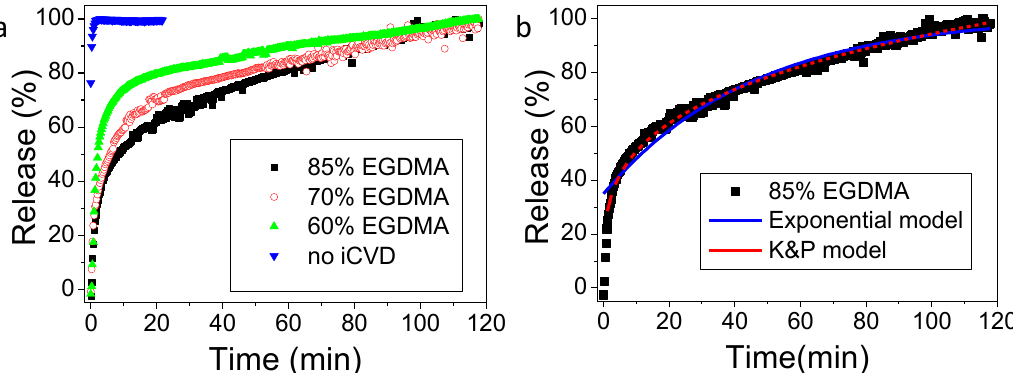
Figure 3. Conductance variation due to the release test from (a) initiated chemical vapor deposition (iCVD) coating alone (white dots) and (b) drug layer with iCVD coating on top (continuous line). Drug layer obtained by drop casting (drop volume = 300 µl, [Gent] = 10 mg/mL), iCVD coating thickness ~200 nm with an EGDMA volume fraction of 46%, immersed in distilled water.